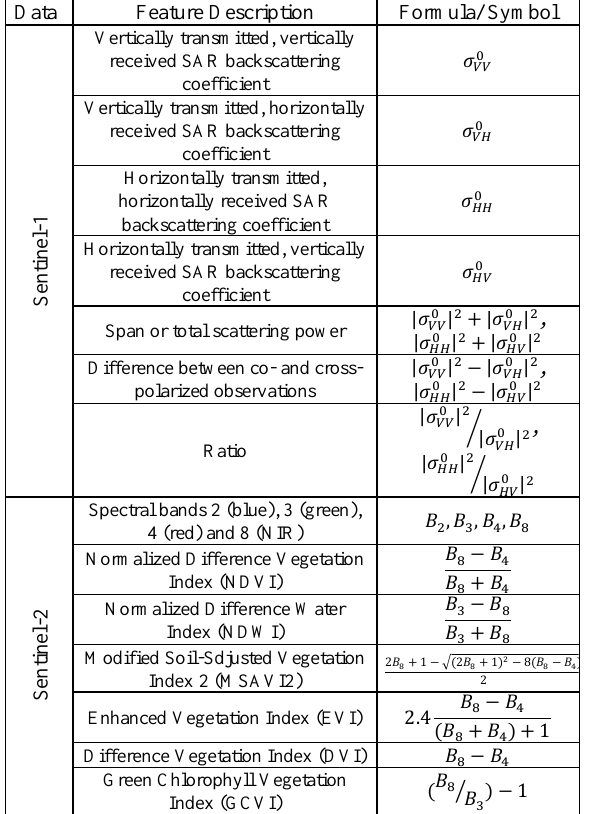
Table 1 . A description of extracted features from SAR and optical imagery.